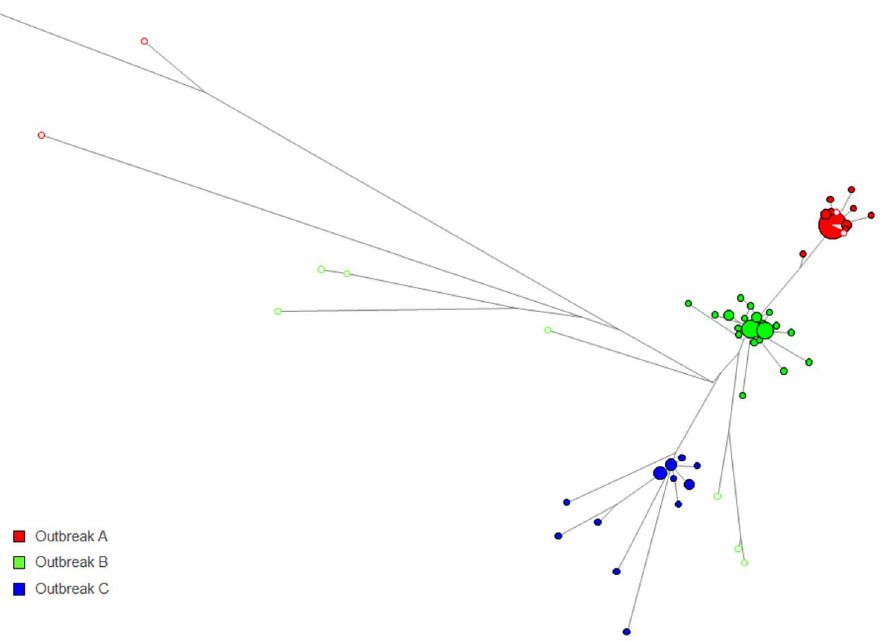
Figure 4. Genetic relationship between HAV strains associated with outbreaks A, B and C. Median joining network analysis was performed using strains from outbreaks A, B and C. Color code is as in Figure 1. Non-outbreak strains (open circles) are also color coded according to the outbreak with which they share the VP1/P2B sequences.